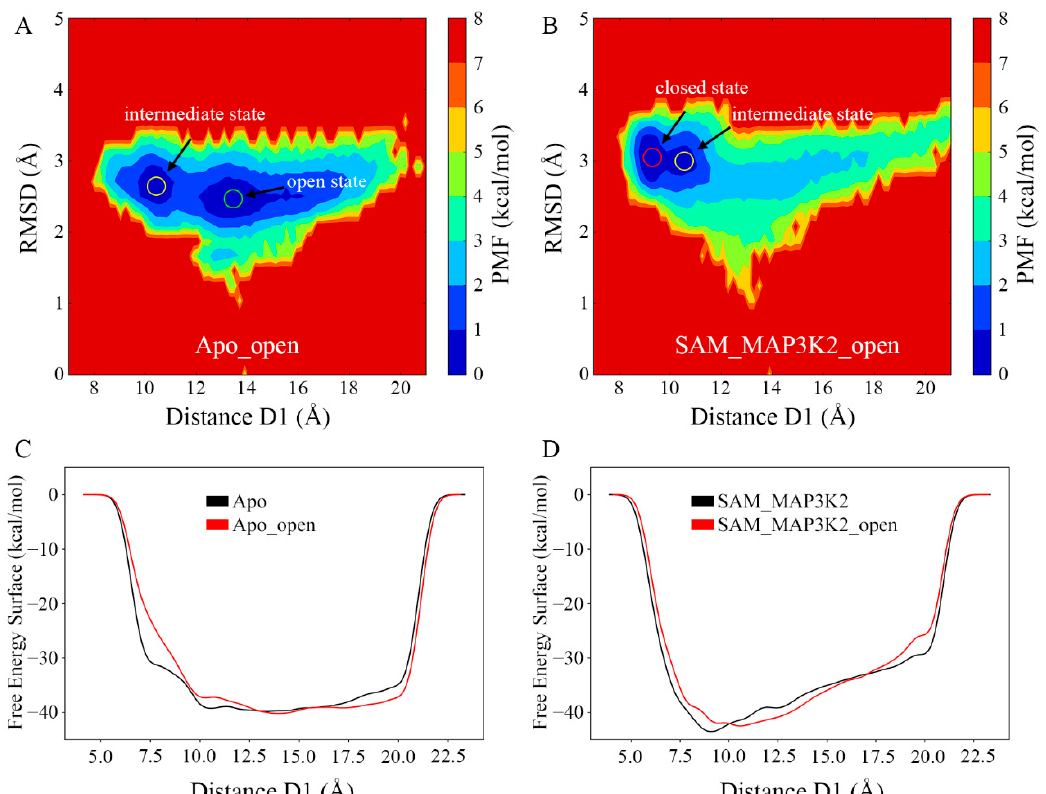
Figure 7. Conformational states of SMYD3 during MD simulations from the open conformation. PMF calculated for the distance D1 vs. the RMSD of SMYD3 for the ( A ) Apo_open and ( B ) SAM_MAP3K2_open systems. ( C , D ) Free energy surface associated with the conformational change of SMYD3 as a function of the distance D1 for the ( C ) Apo (black) and Apo_open (red), and ( D ) SAM_MAP3K2 (black) and SAM_MAP3K2_open (red) systems.